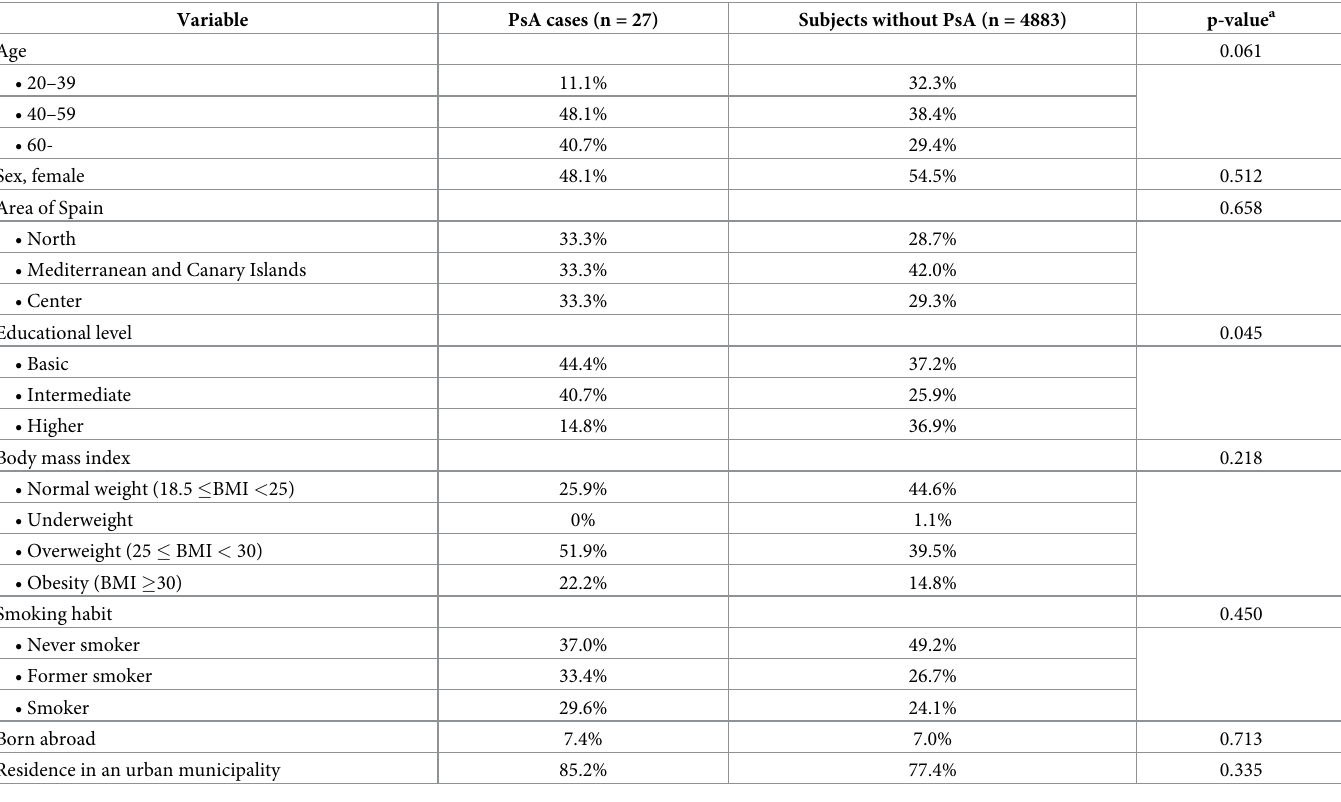
Table 1. Association between presence of psoriatic arthritis and sociodemographic, anthropometric and lifestyle variables. Bivariate analysis.